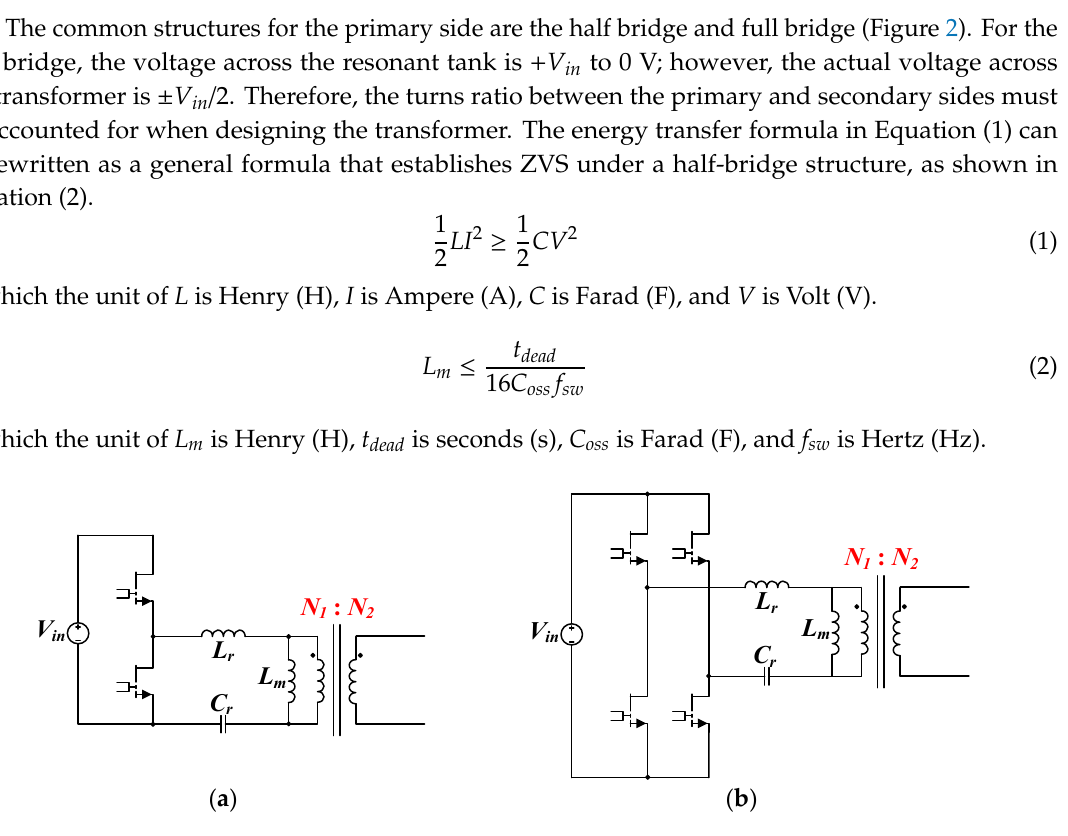
Figure 2. Primary structure ( a ) half bridge and ( b ) Full bridge topology.